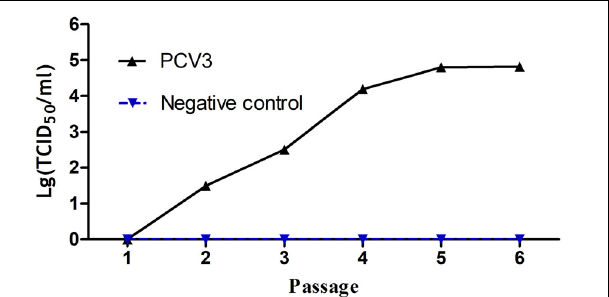
FIGURE 6 | Growth curves of the cloned virus strains after a series of passages. The virus titers increased with the number of passages. The virus titers strikingly increased since the second passage and reached up to 10 4 . 8 TCID 50 /ml at the sixth